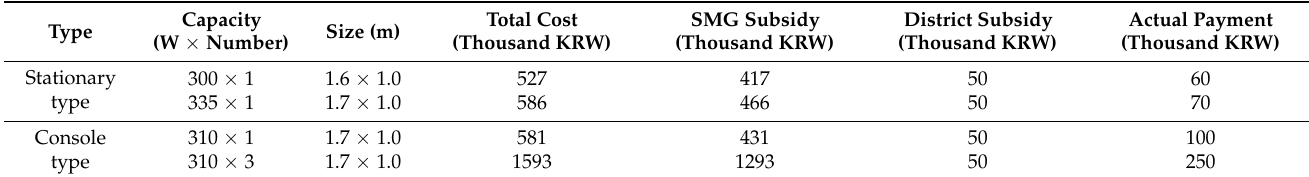
Table 3. 2019 Mini PV installation subsidy [42,43].